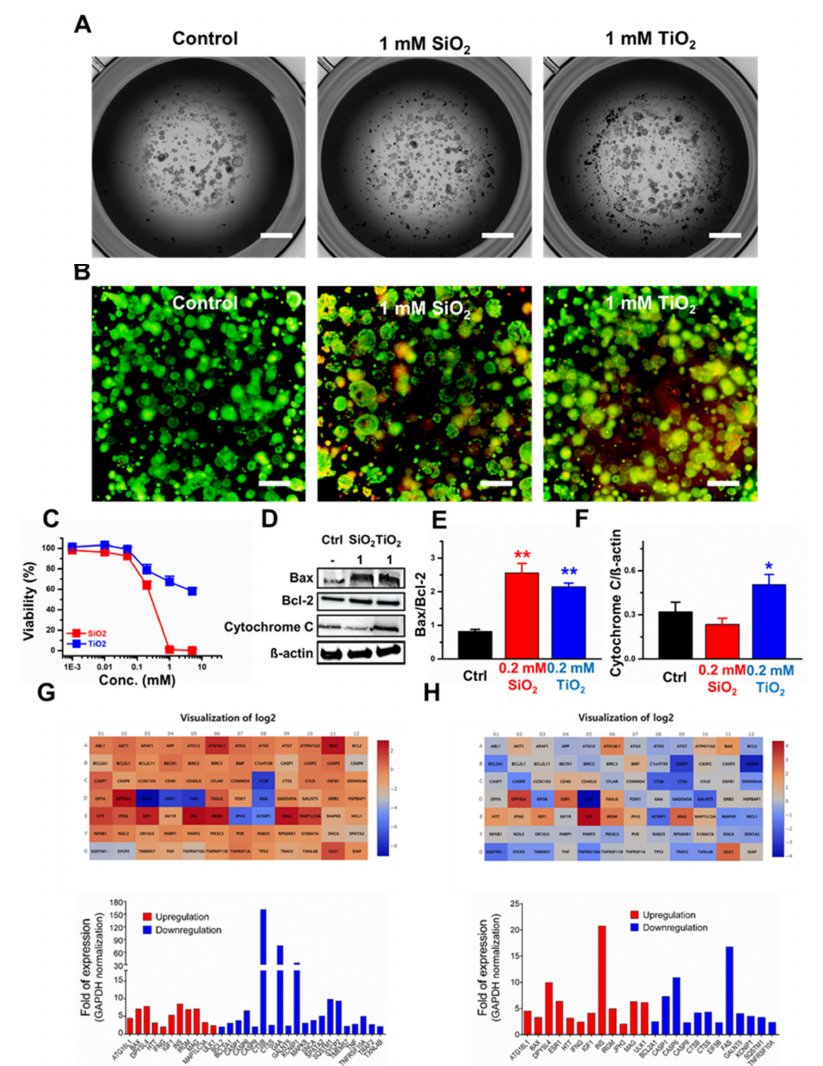
Figure 5. Human colon organoid toxicity induced by the SiO 2 and TiO 2 nanoparticles. ( A ) Bright field images of control-SiO 2 nanoparticle-and TiO 2 nanoparticle-incubated human colon organoids. The scale bar represents 200 µ m. ( B ) Live / dead assay. Scale bars represent 150 µ m. ( C ) Concentration-dependent viability. ( D ) Western blot. ( E ) Quantitative analysis of the Bax / Bcl-2 protein expression